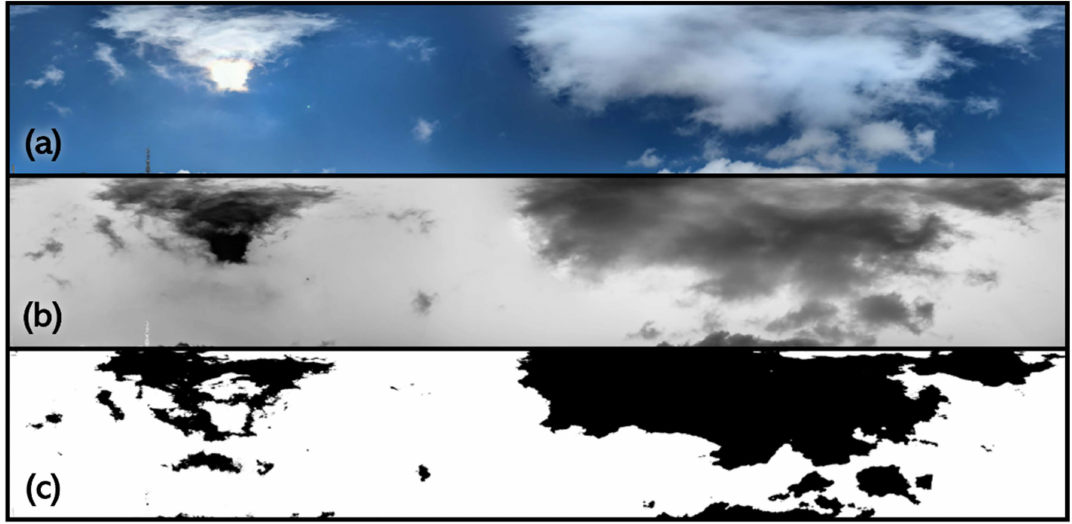
Figure 5. Example of ( a ) RGB image, ( b ) the grey image and ( c ) its binarization (corresponding to the initial stage). Estimated cloud fraction resulted in 24%.